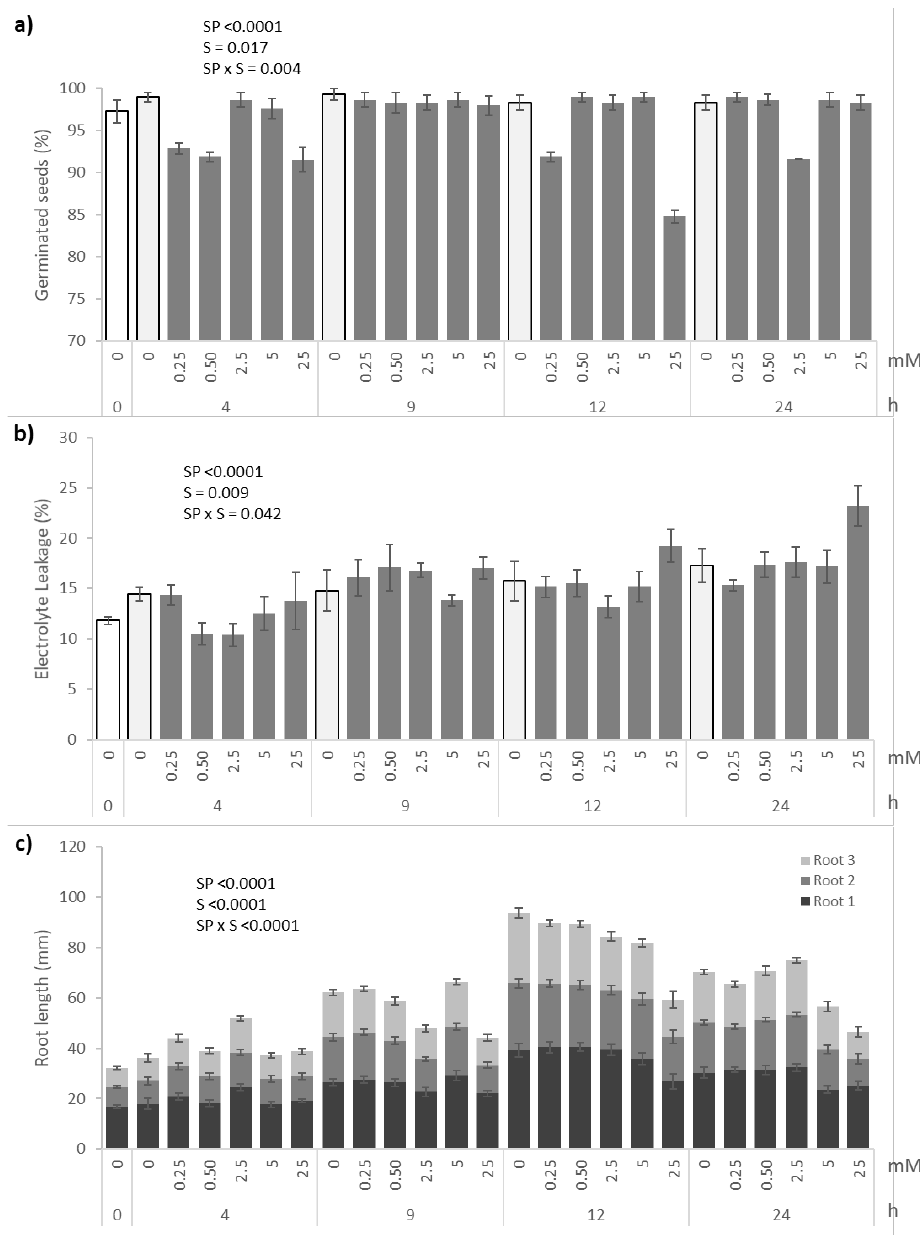
Figure 2. Germinated seeds ( n = 45) ( a ), electrolyte leakage of seed membrane ( n = 15) ( b ) and root length sum from the three major roots ( n = 45) ( c ), forty-eight hours after sowing. Five soaking periods (SP = 0, 4, 9, 12 and 24 h) and six concentrations of sodium selenate (S = 0, 0.25, 0.5, 2.5, 5 and 25 mM) were studied. Values are mean ± standard error. Two-away ANOVA p -values for SP, S and interaction SP × S were shown for each parameter. Complementary information on statistical significance is available in Supplementary Table S1.